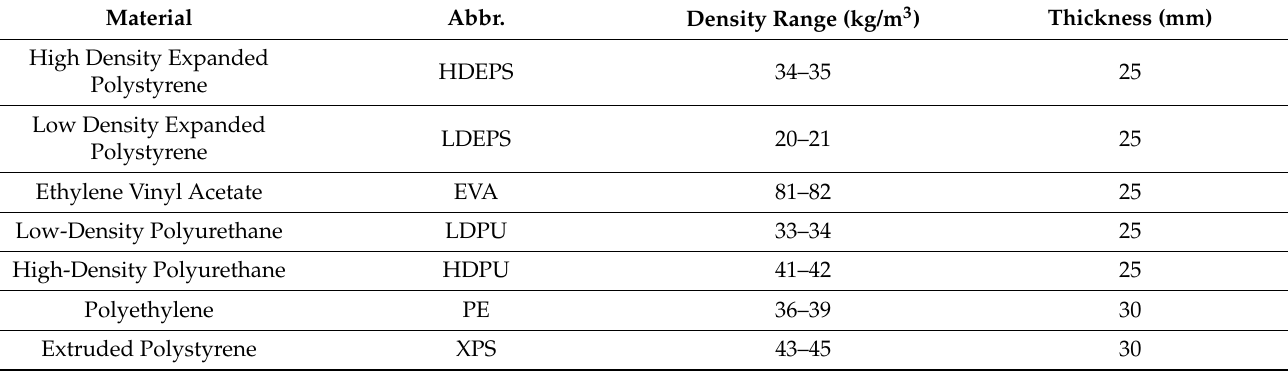
Table 1. Material sample abbreviations and